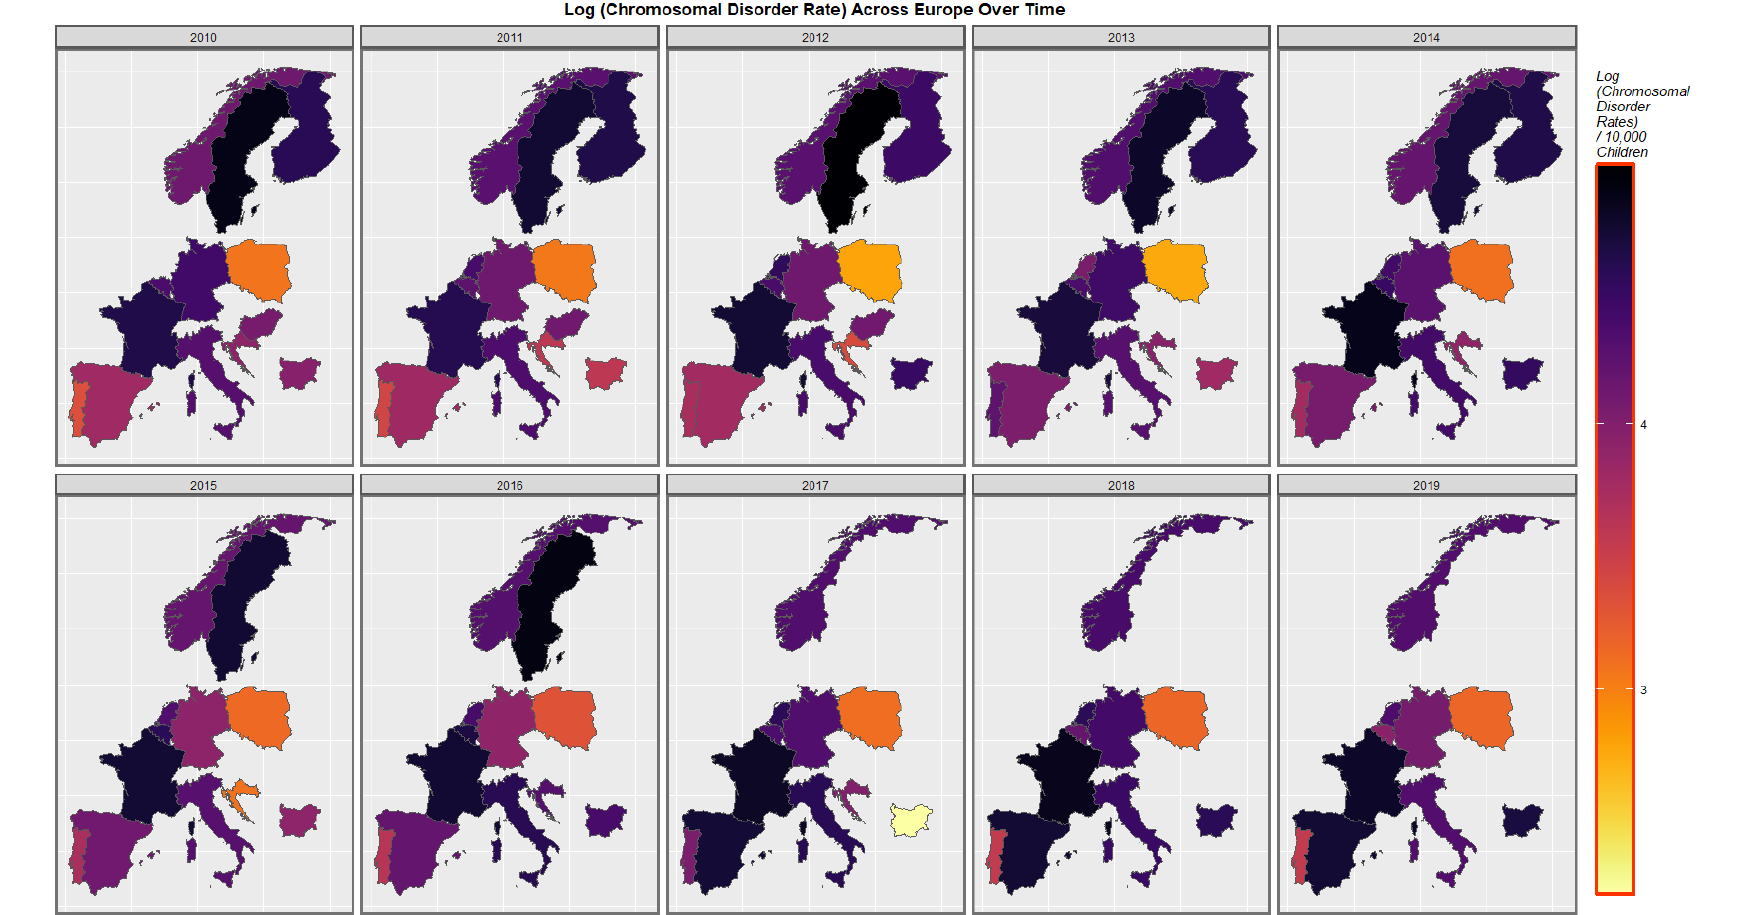
Figure 3. Sequential map-graph of chromosomal disorders over time in selected European nations 2010–2019.